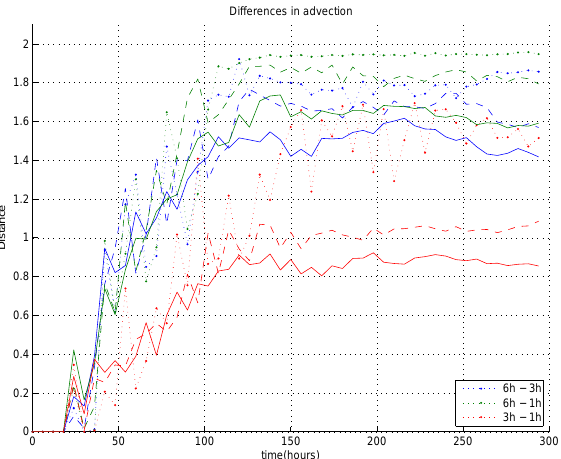
Fig. 4. Distance between trajectory clouds (average for ensembles initialised at 16, 17 and 18km along the vertical HIBISCUS profile) as a function of backwards advection time for different advecting winds and turbulent diffusivities. Blue: distance between 6 hourly and 3 hourly winds ( C 6 h − C 3 h ), Green: distance between 6 hourly and 1 hourly winds ( C 6 h − C 1 h ), Red: distance between 3 hourly and 1 hourly winds ( C 3 h − C 1 h ). Dotted lines: D =0.1m 2 s − 1 . Dashed lines: D =0.5m 2 s − 1 . Continuous lines: D =1m 2 s − 1 . The abscissa represents time of backward advection in hours. The ordinate correspond to the function distance (dist ( C 1 ,C 2 ; t )= R | f ( C 1 ; x,t ) − f ( C 2 ; x,t ) | dx , where f ( C ; x,t ) is the probability distribution in space of the cloud C at time t ) between pairs of particle clouds, dimensionless.